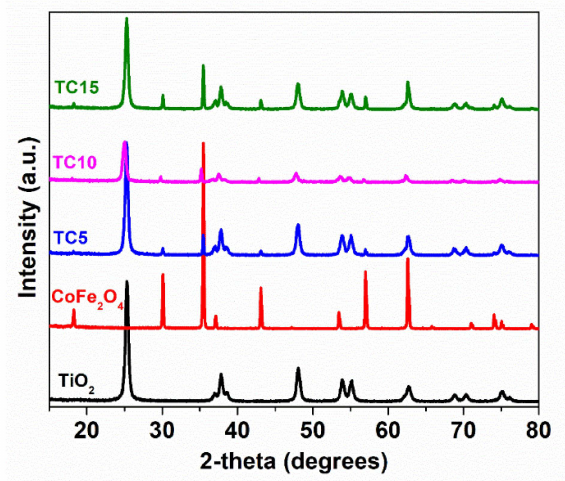
Figure 2. XRD patterns of the synthesized photocatalysts.